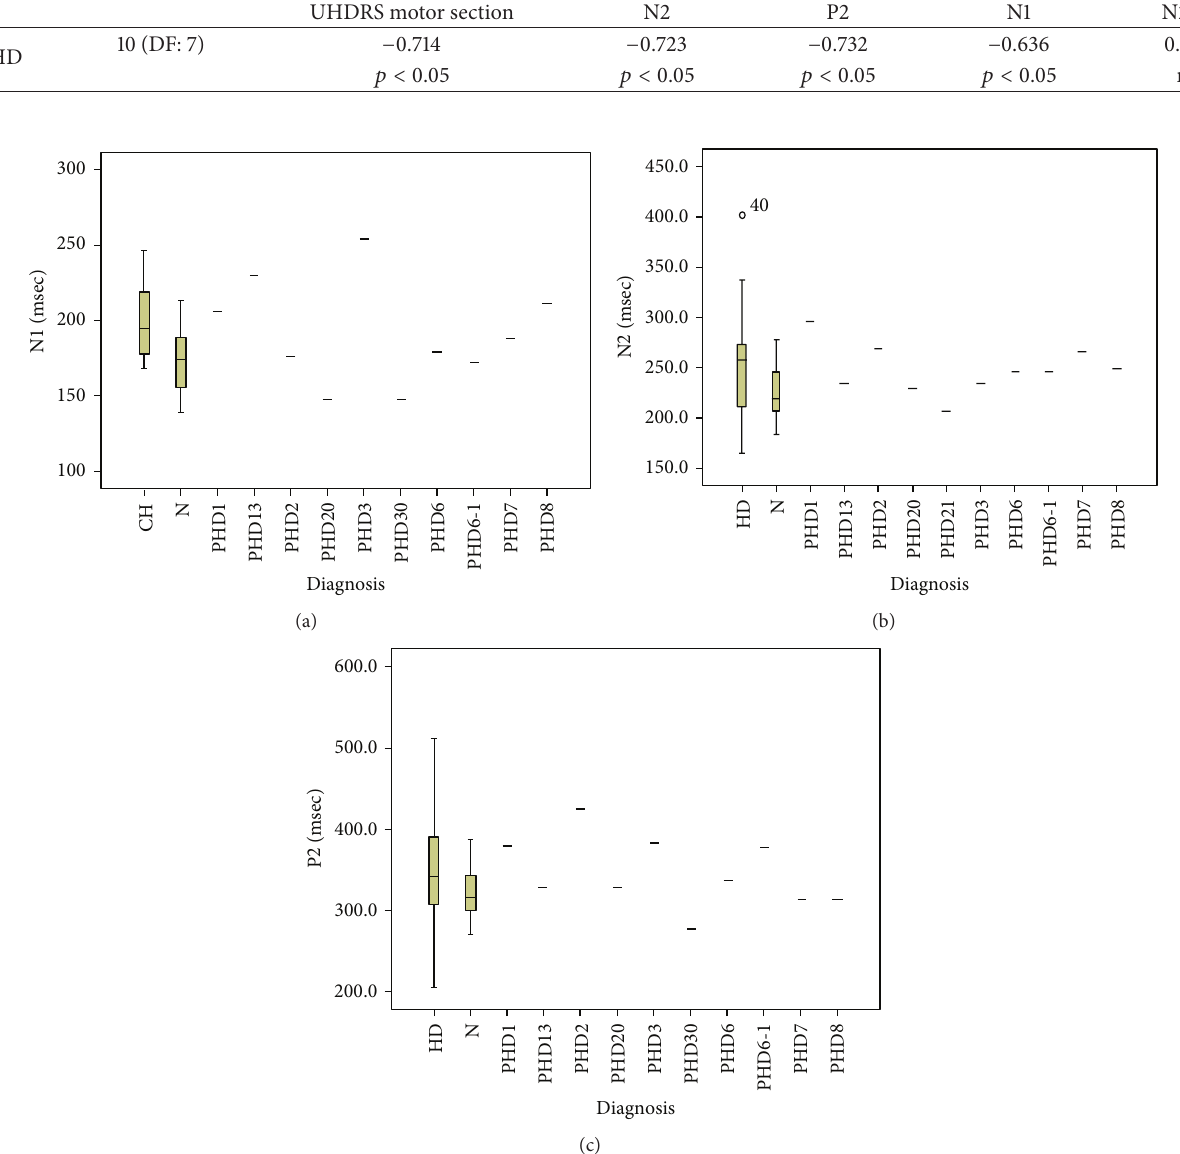
Figure 2: The N1 (a), N2 (b), and P2 (c) latency values are shown for single PHD (presymptomatic HD) cases and N (normal) and HD groups (95% CI). The values are corrected for age. The numbers following the PHD title expressed the expected time of illness onset (in years). Only the PHD21 case, who was an 18-year-old girl, showed values in the lower normal limits. The cases PHD1, PHD2, and PHD3 with a risk for manifest chorea within little time presented with P2 latency in the upper normal limits. The case PHD1 showed significant prolongation of N2 latency. The case PHD2 had significant prolongation of N1